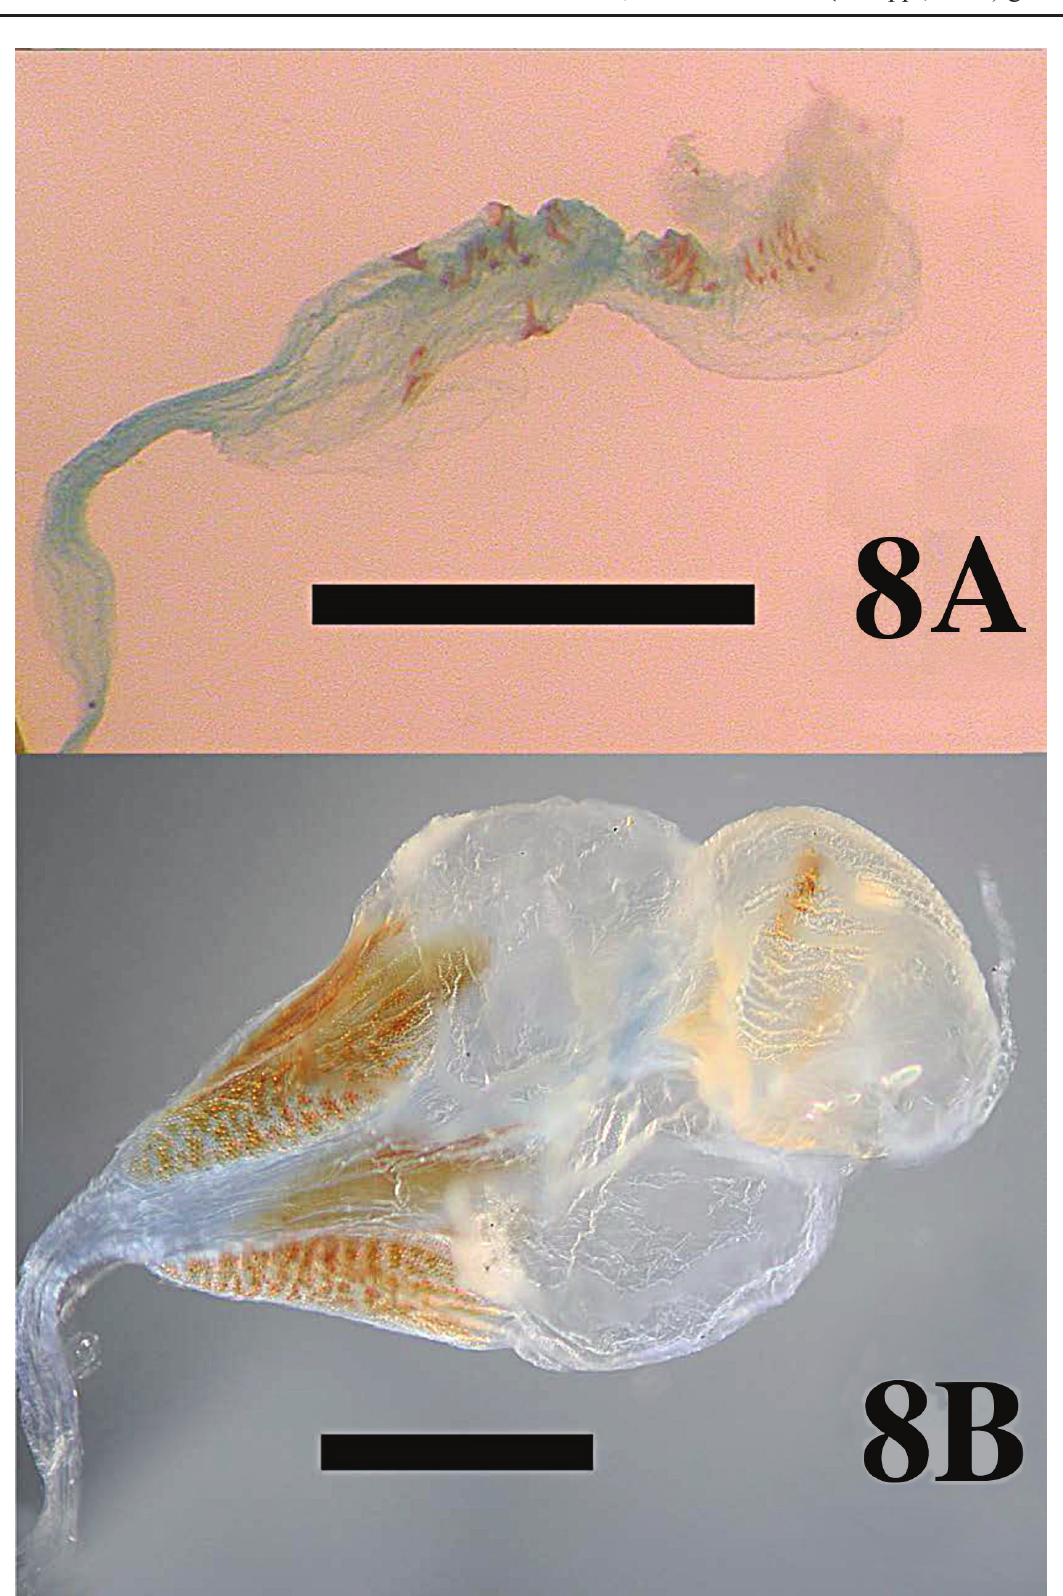
Fig. 8. Female genitalia. A . Sharon amoenus (Philippi, 1861) comb. nov. B . Hemicrepidius memnonius herbst, 1806 . scale bars =